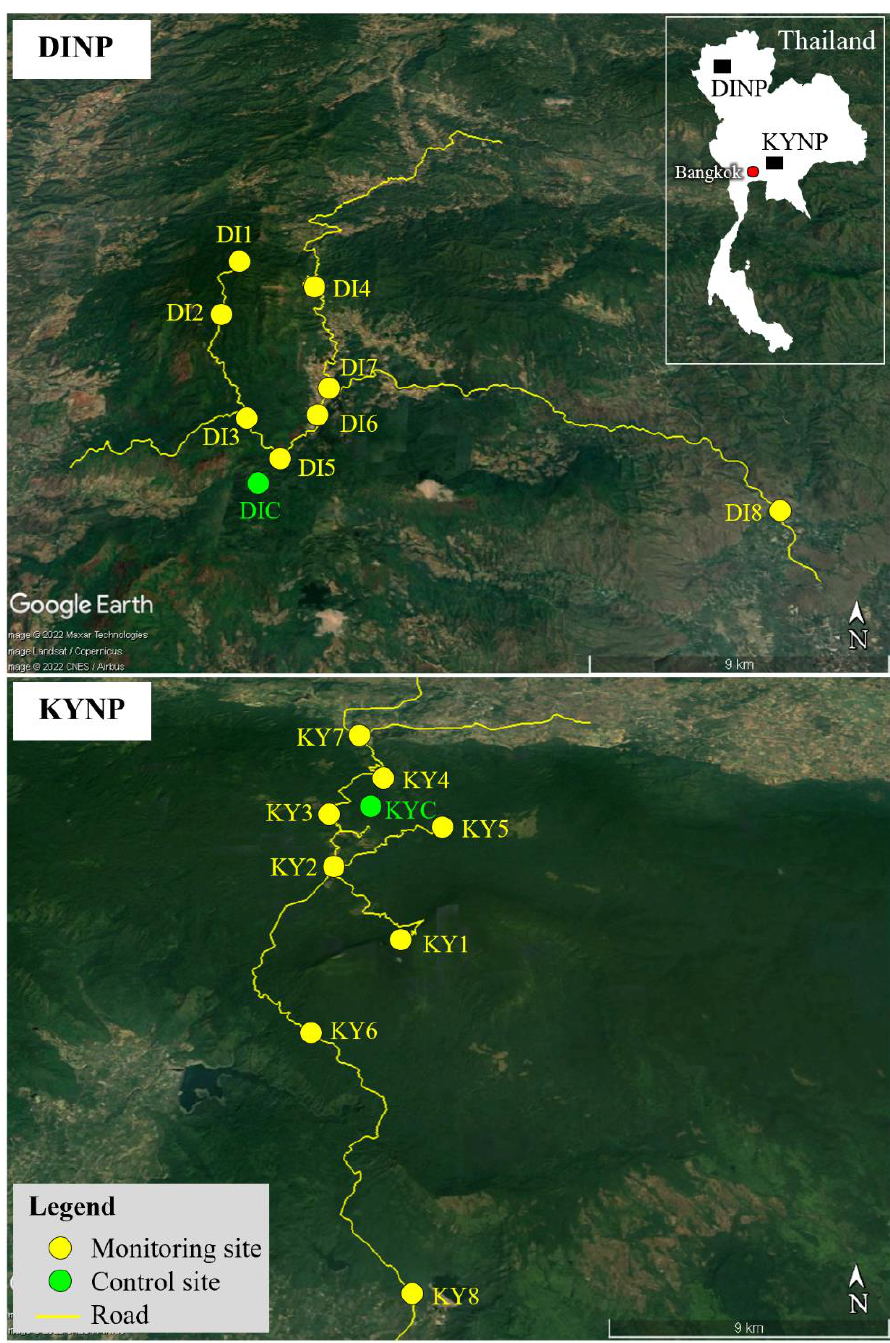
Figure 1. Locations of control (KYC, DIC) and monitoring (KY1 – KY8, DI1 – DI8) sites in Khao Yai National Park (KYNP) and Doi Inthanon National Park (DINP) in Thailand.